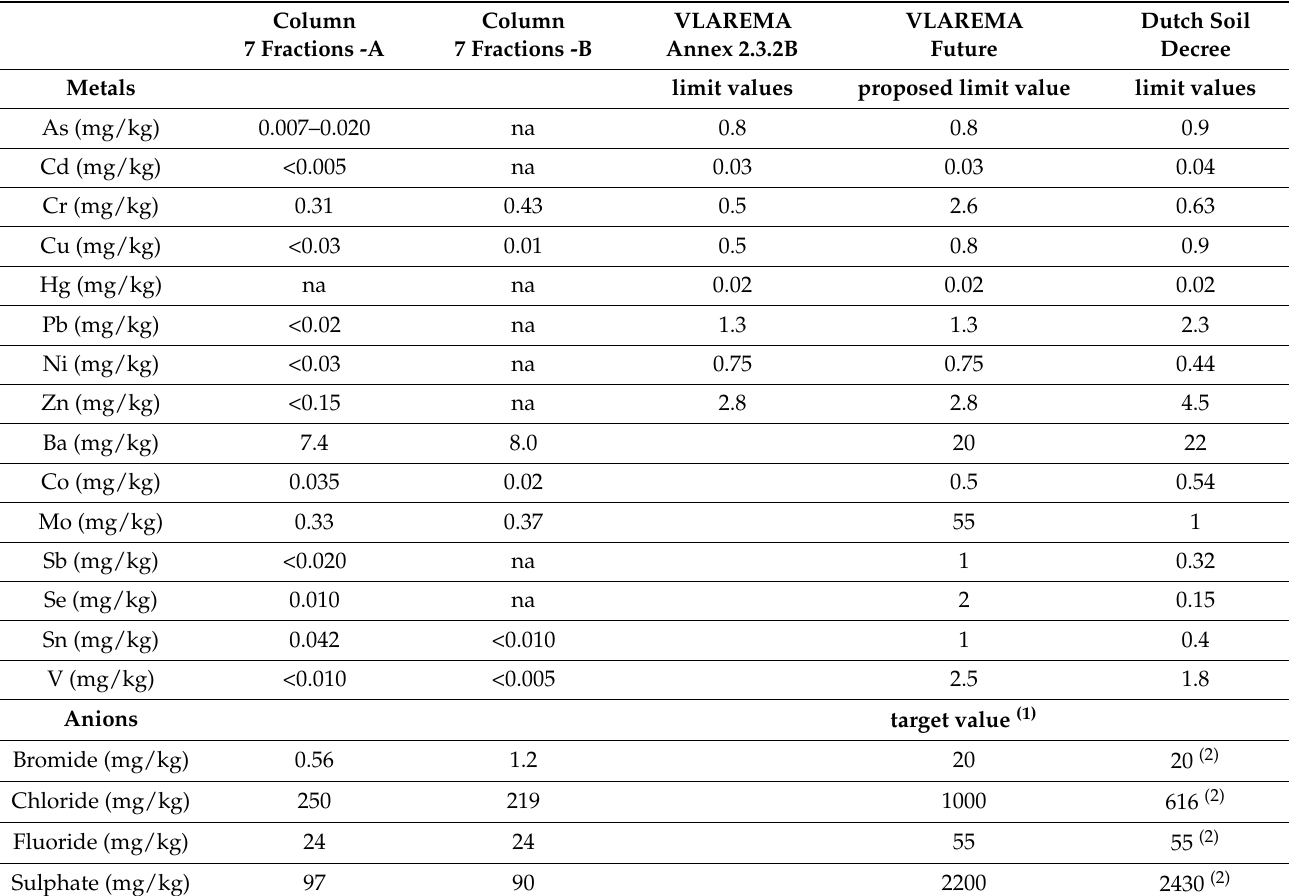
Table 5. Results leaching concrete mix (350 kg/m 3 CEM I), with replacement of fine (0–4 mm) and coarse aggregates (4–20 mm) with recycled aggregate from crushed Carbstone pavers. na = not